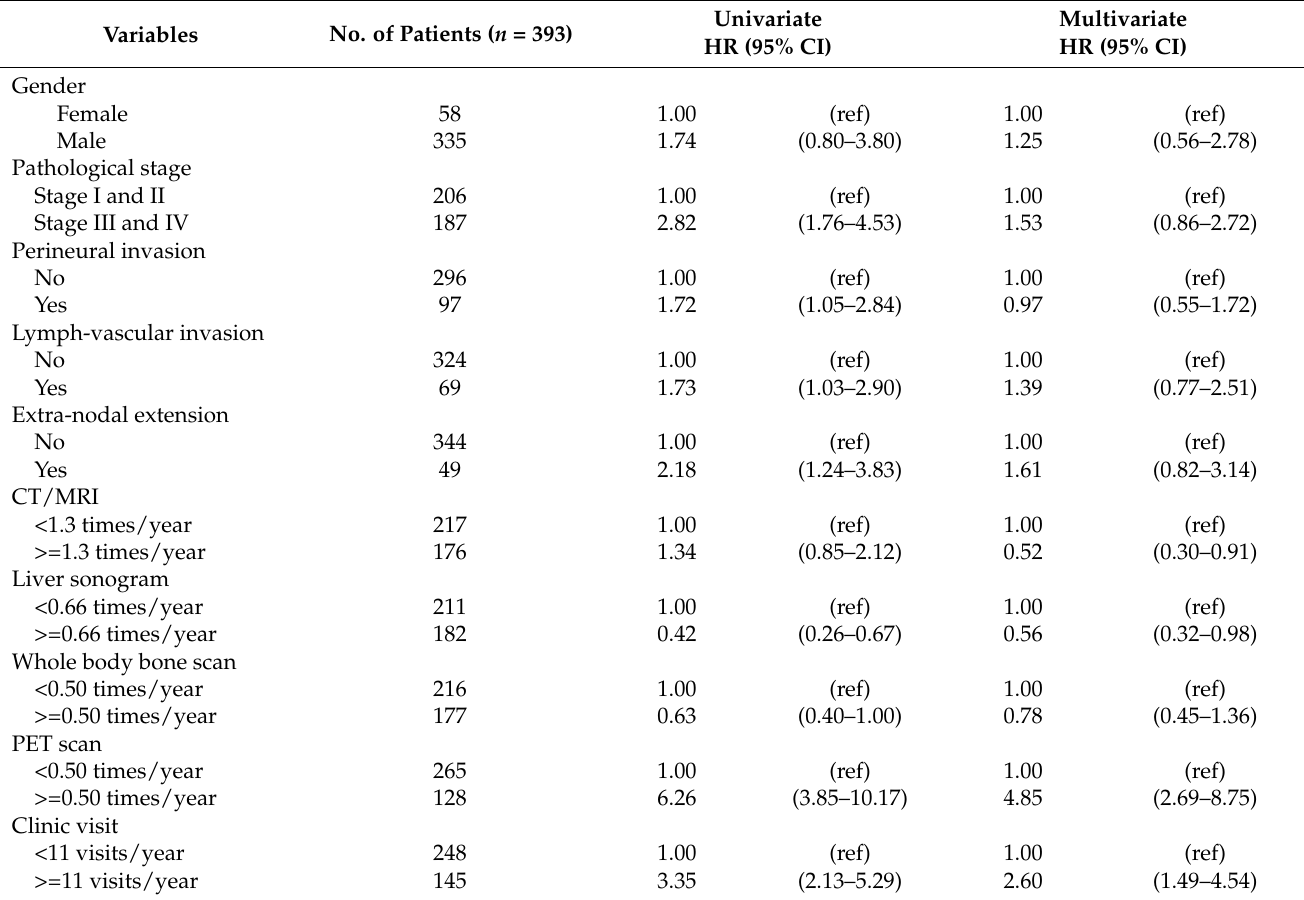
Table 7. Factors associated with disease-specific survival in elder oral cavity cancer